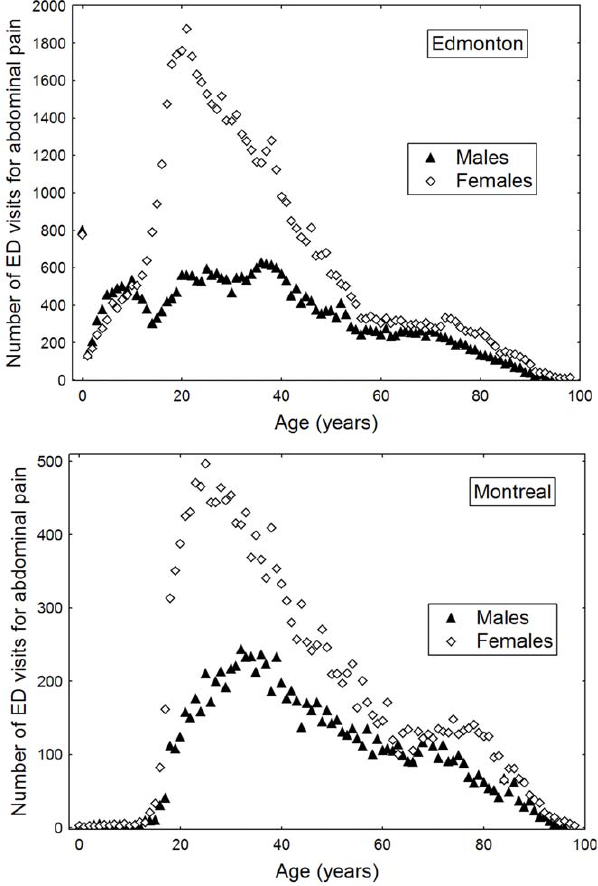
Figure 1. Age-specific frequency of admissions to emergency departments (ED) for non-specific abdominal pain stratified by sex.